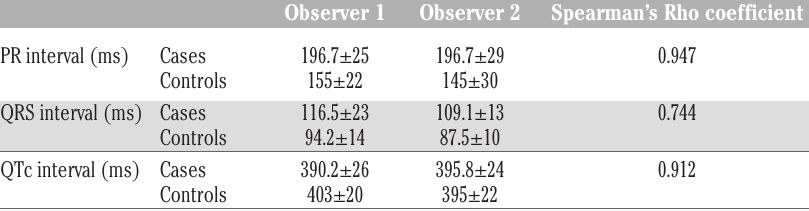
Table 2. Concordance between the two observers for electrocardiogram measurements expressed by Spearman’s Rho correlation coefficient (0: no concordance, 1: full concor-